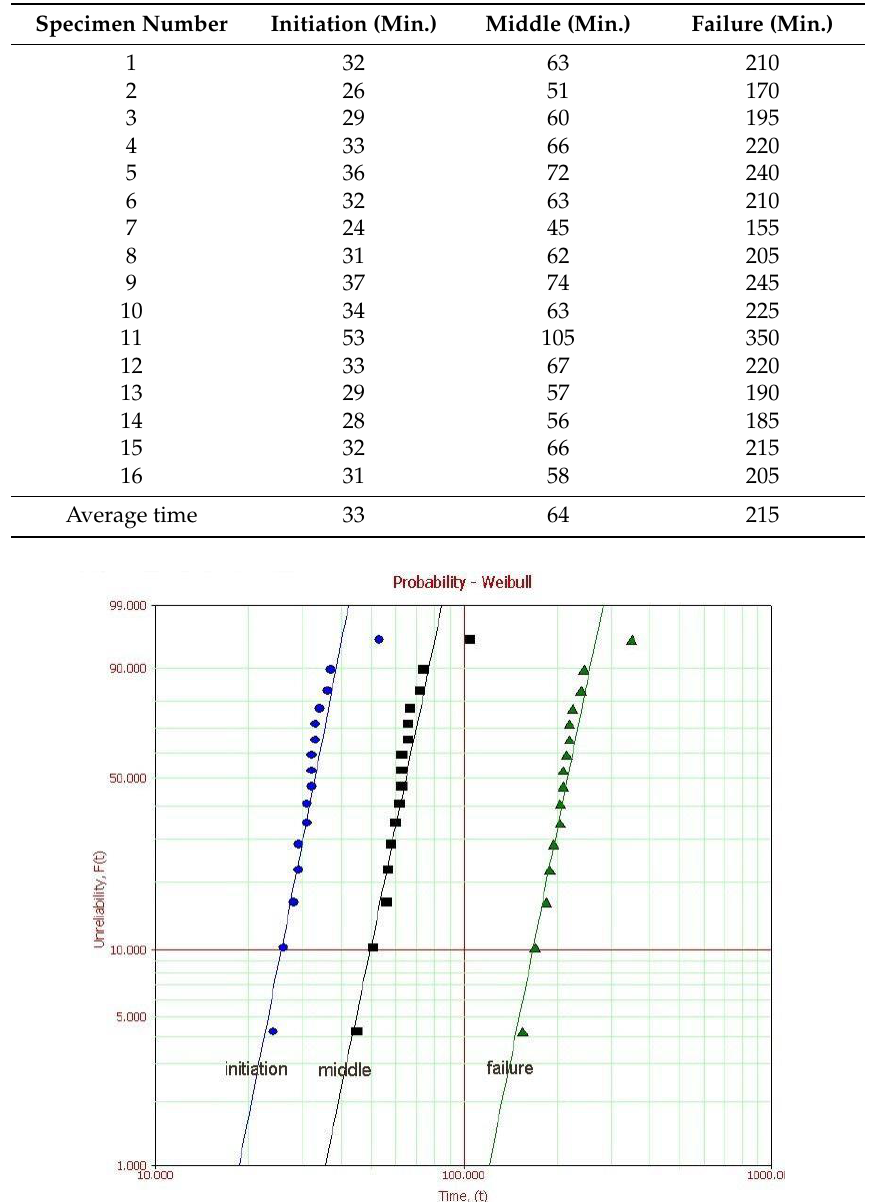
Table 3. Time to failure of tree model 2.